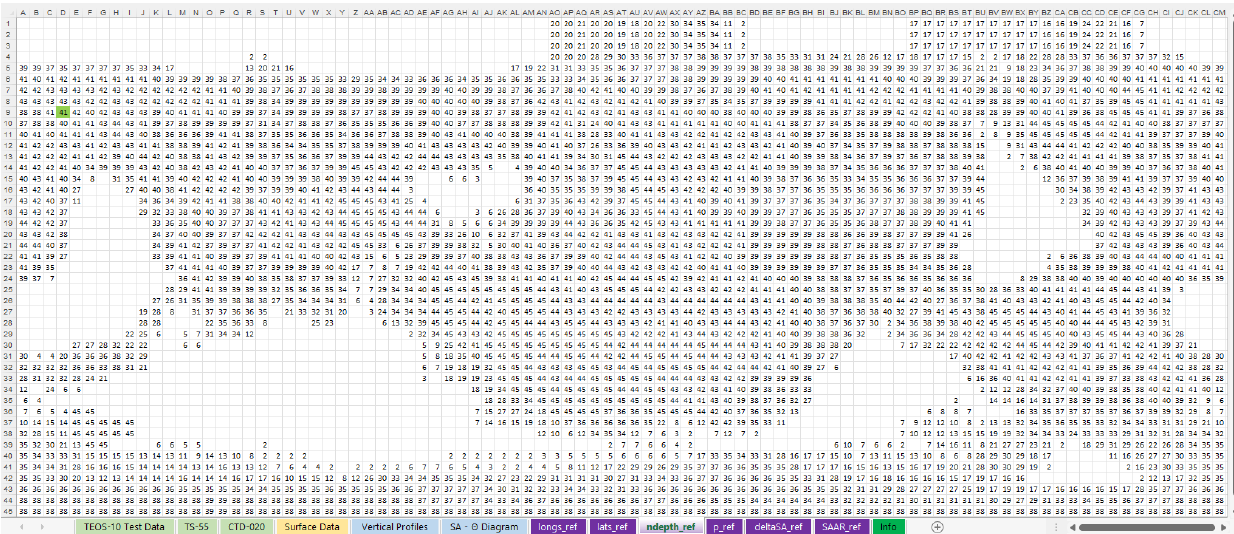
Figure 6. The [ndepth_ref] look-up table. The table has 45 rows (latitude) by 91 columns (longitude). South is at the top (first row is 86 ◦ S) and first column is 0 ◦ of longitude. The latitude × longitude grid is a 4 ◦ × 4 ◦ grid and each cell location is obtained from the [longs_ref] and [lats_ref] tables. Cell values are the number of pressure levels at the given location. The cell highlighted in green is used as a case study in the